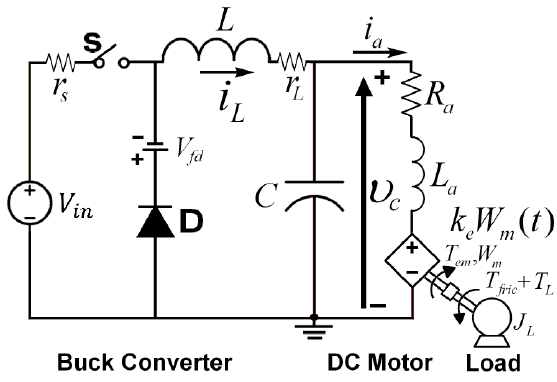
Figure 2. Diagram of the buck converter connected to a DC motor. Table 2. Parameters of the buck-motor system.